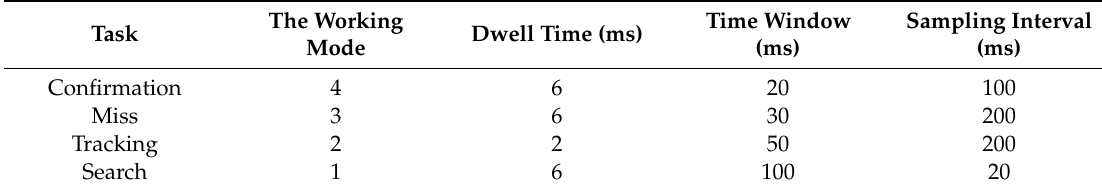
Table 2. Radar task